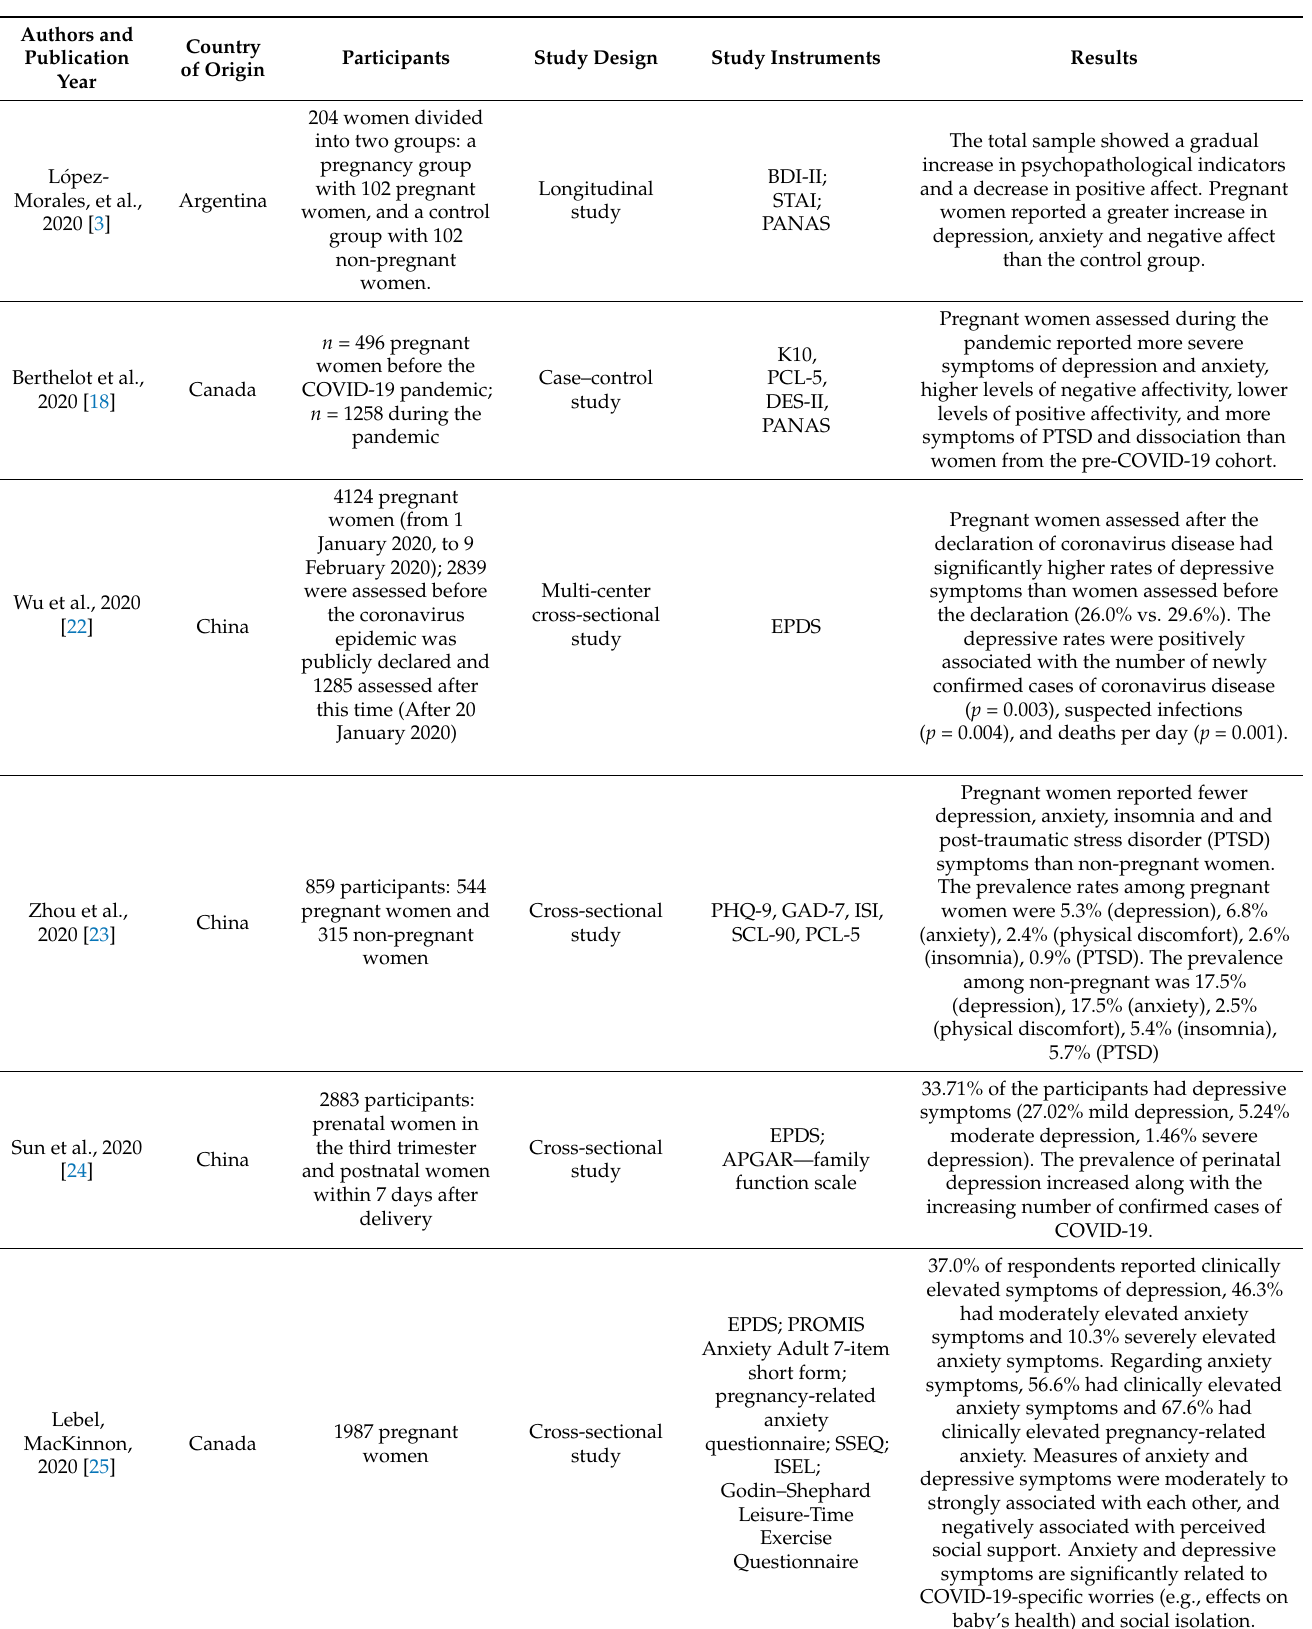
Table 1. Studies of mental health concerns related to COVID-19 in pregnant and/or postpartum women, considering countries of recruitment, main characteristics of the sample, methodology and tools of measurement, and main